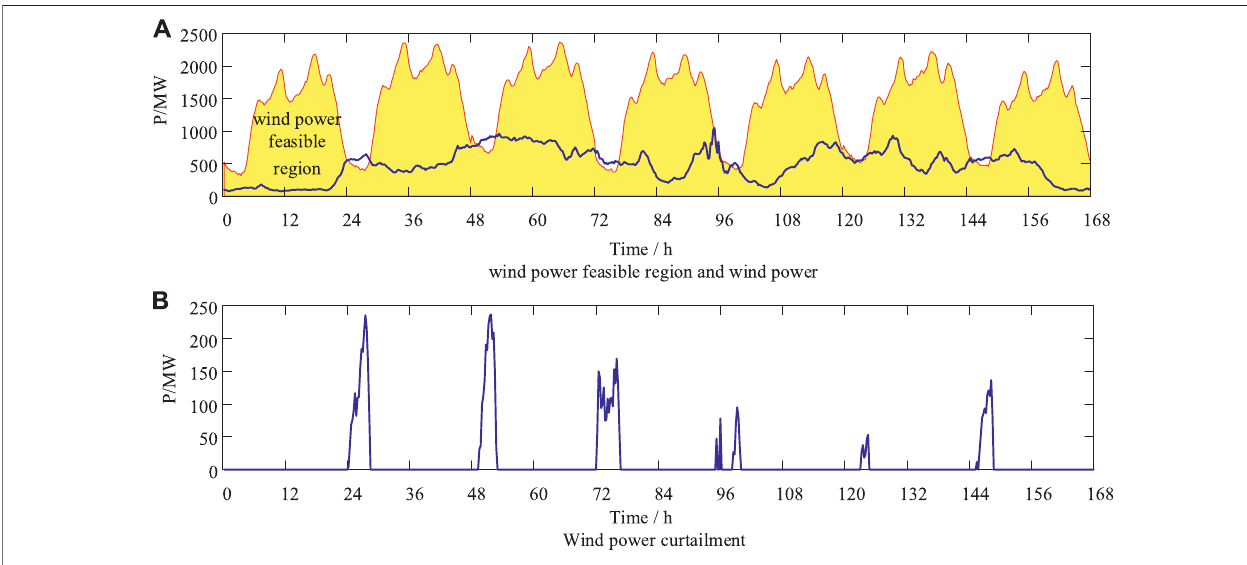
FIGURE 1 | Wind power consumption space and wind power curtailment.